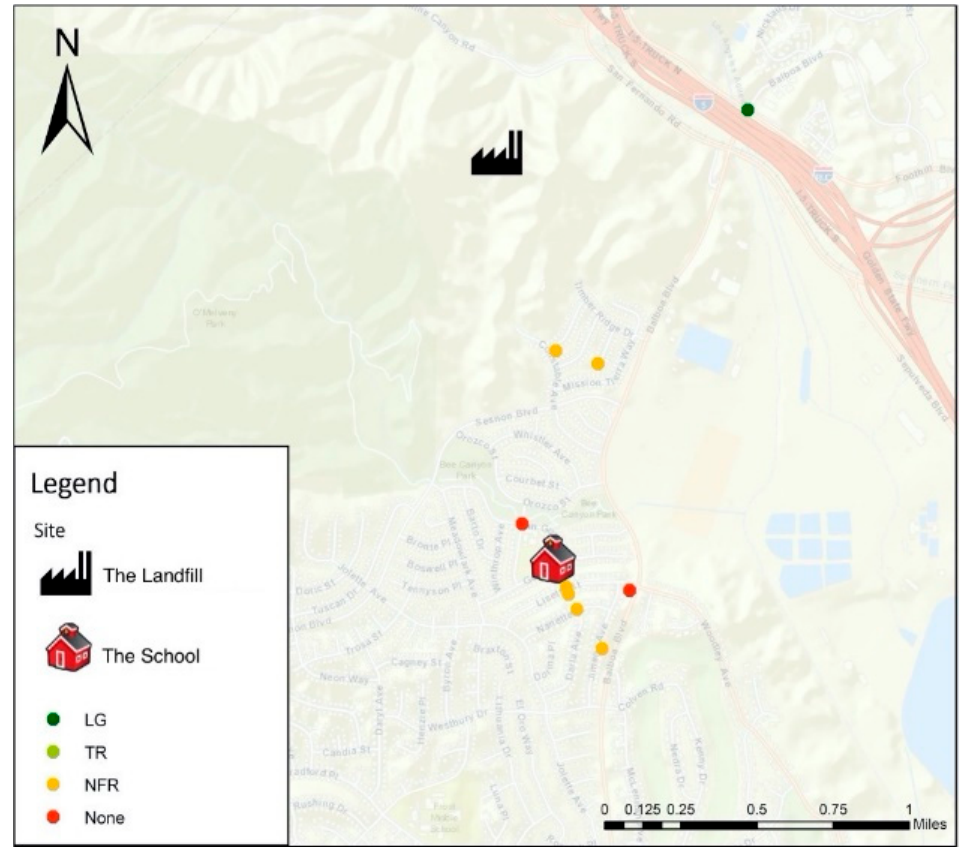
Figure 8. Odor complaints near the school during the Odor Patrol time period: 6–9 a.m., 2017–2018. The dots do not represent each complaint, only the general location of complaints. LG–Landfill Gas, TR–Trash Odor, NFR–No Field Response. The South Coast Air Quality Management District (SCAQMD) inspector did not go to the location. None: No odor was detected by SCAQMD inspectors at the complaint site.